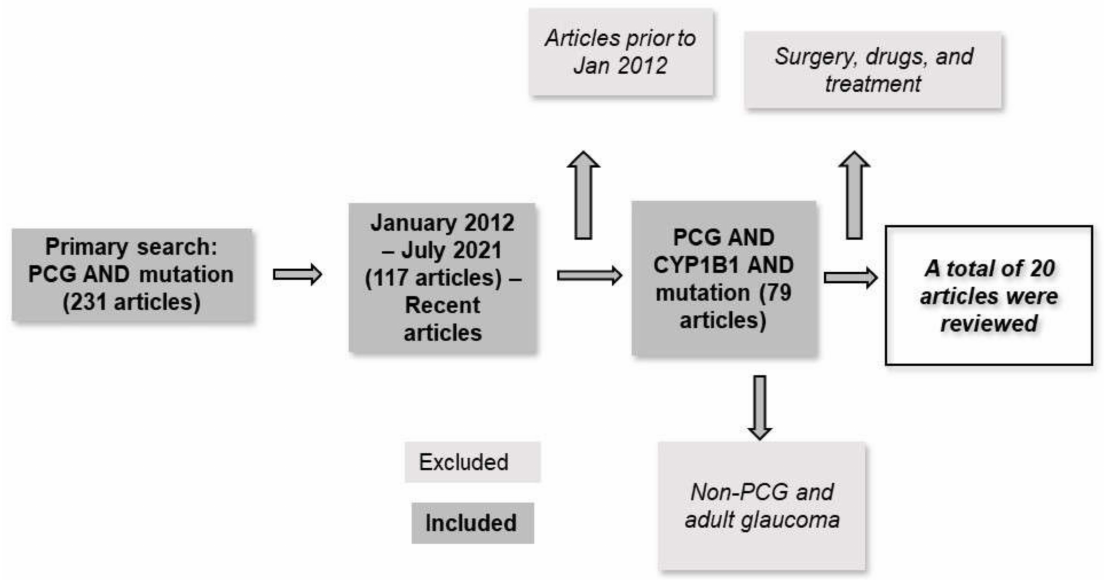
Figure 1. Flow chart of the search strategy steps for the reviewed articles. PubMed was searched from 2012 to 2021. A total of 20 articles were